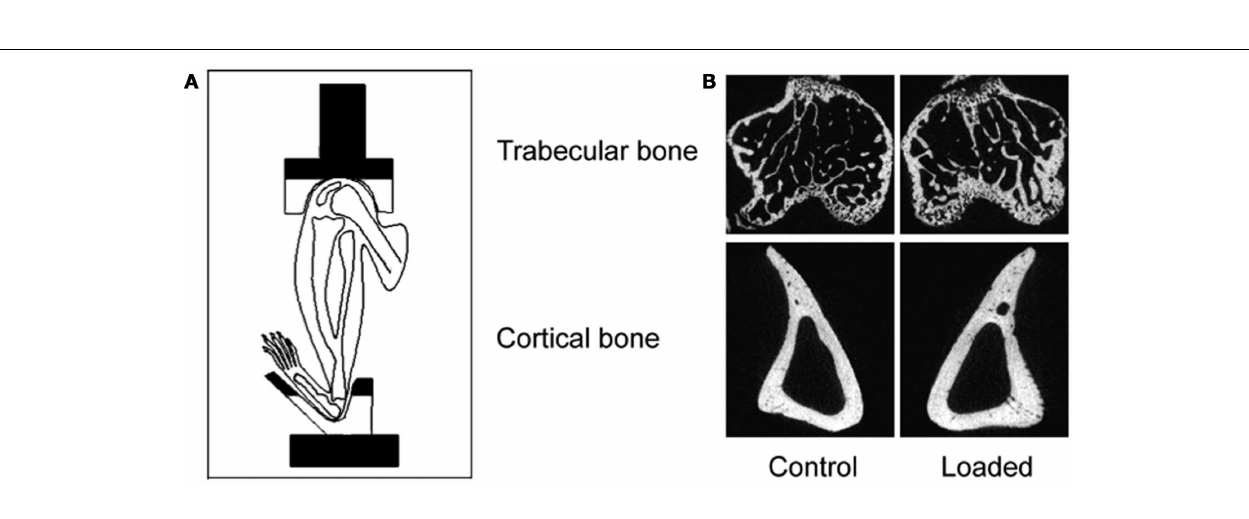
compartments in a single loaded bone (34). (B) Representative µ CT scans demonstrating trabecular and cortical bone formation within a single loaded bone